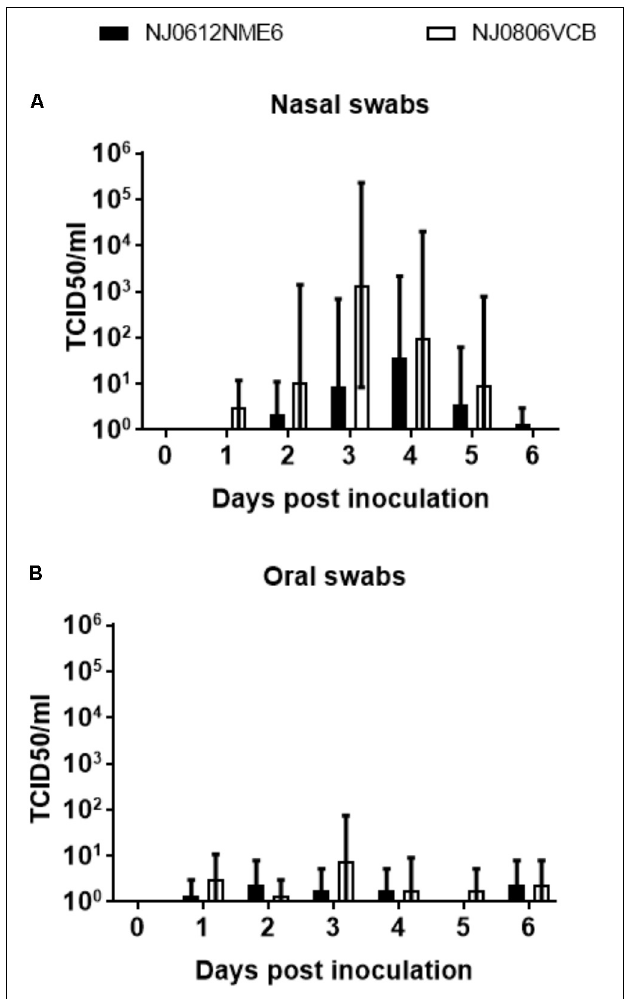
FIGURE 9 | Detection of infectious virus in clinical samples. Infectious virus was isolated in Vero cells from (A) nasal swabs or (B) oral swabs after infection with NJ0612NME6 or NJ0806VCB at expressed days post-infection. Positive isolations were confirmed by rRT-PCR and viral titrations were conducted in Vero cells. Viral titers are expressed in TCID 50 /ml.